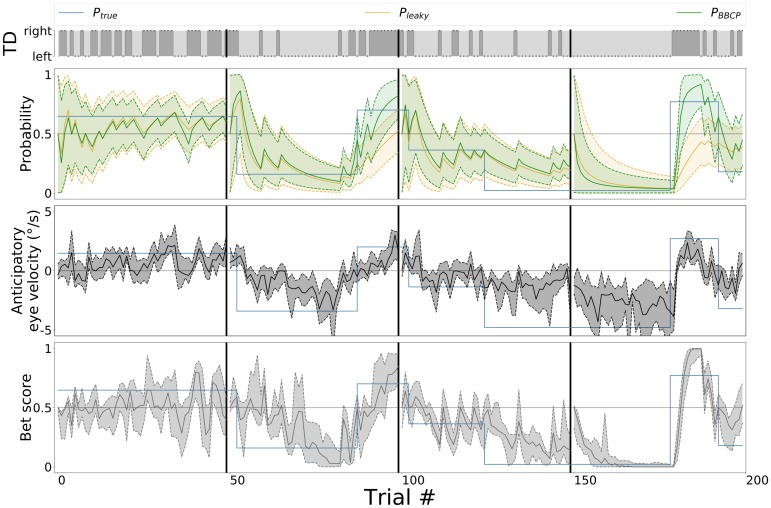
Binary Bayesian Change-Point (BBCP) detection model.(A) This plot shows a synthesized sequence of 13 events, either a leftward or rightward movement of the target (TD). Run-length estimates are expressed as hypotheses about the length of an epoch over which the probability bias was constant, that is, the number of trials since the last switch. Here, the true probability bias switched from a value of .5 to .9 at trial 7, as can be seen by the trajectory of the true run-length (blue line). The BBCP model tries to capture the occurrences of a switch by inferring the probability of different possible run-lengths. At any new datum (trial), this defines a Hidden Markov Model as a graph (trellis), where edges indicate that a message is being passed to update each node’s probability (as represented by arrows from trial 13 to 14). Black arrows denote a progression of the run-length at the next step (no switch), while gray lines stand for the possibility that a switch happened: In this case the run-length would fall back to zero. The probability for each node is represented by the grey scale (darker grey colors denote higher probability) and the distribution is shown in the inset for two representative trials: 5 and 11. Overall, this graph shows how the model integrates information to accurately identify a switch and produce a prediction for the next trial (e.g. for t = 14). (B) On a longer sequence of 200 trials, representative of a trial block of our experimental sequence (see Fig 1A), we show the actual events which are observed by the agent (TD), along with the (hidden) dynamics of the true probability bias Ptrue (blue line), the value inferred by a leaky integrator (Pleaky, orange line) and the results of the BBCP model in estimating the probability bias PBBCP (green line), along with .05 and .95 quantiles (shaded area). This shows that for the BBCP model, the accuracy of the predicted value of the probability bias is higher than for the leaky integrator. Below, we show the belief (as grayscales) for the different possible run-lengths. The green and orange line correspond to the mean run-length which is inferred, respectively, by the BBCP and leaky models: Note that in the BBCP, while it takes some trials to detect switches, they are in general correctly identified (transitions between diagonal lines) and that integration is thus faster than for the leaky integrator, as illustrated by the inferred value of the probability bias.